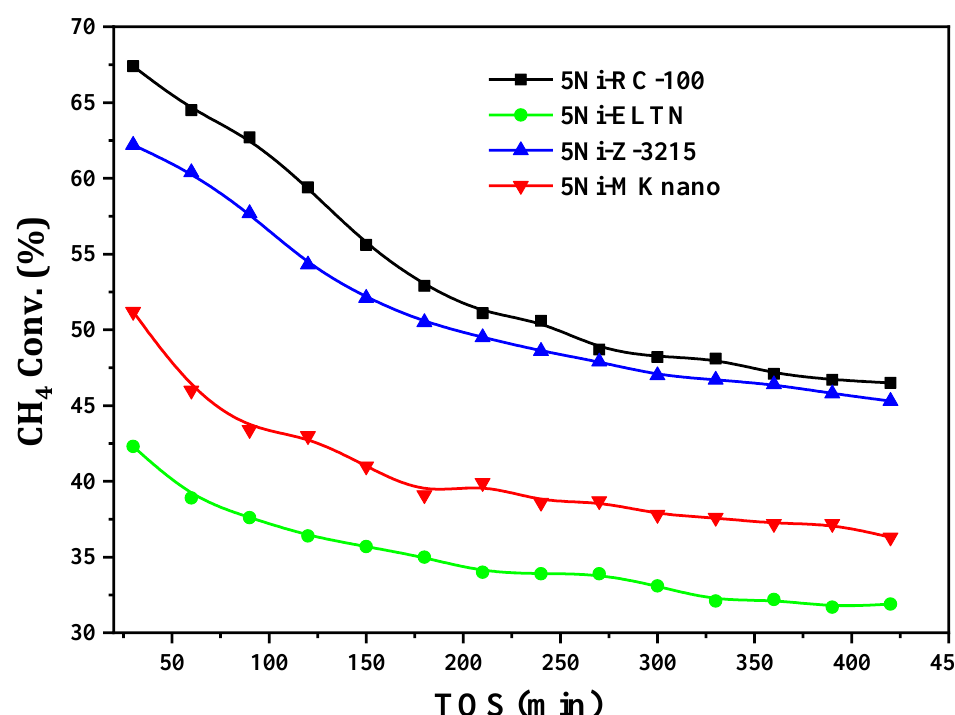
Figure 6. CH 4 conversion for different source zirconia-supported Ni catalysts.